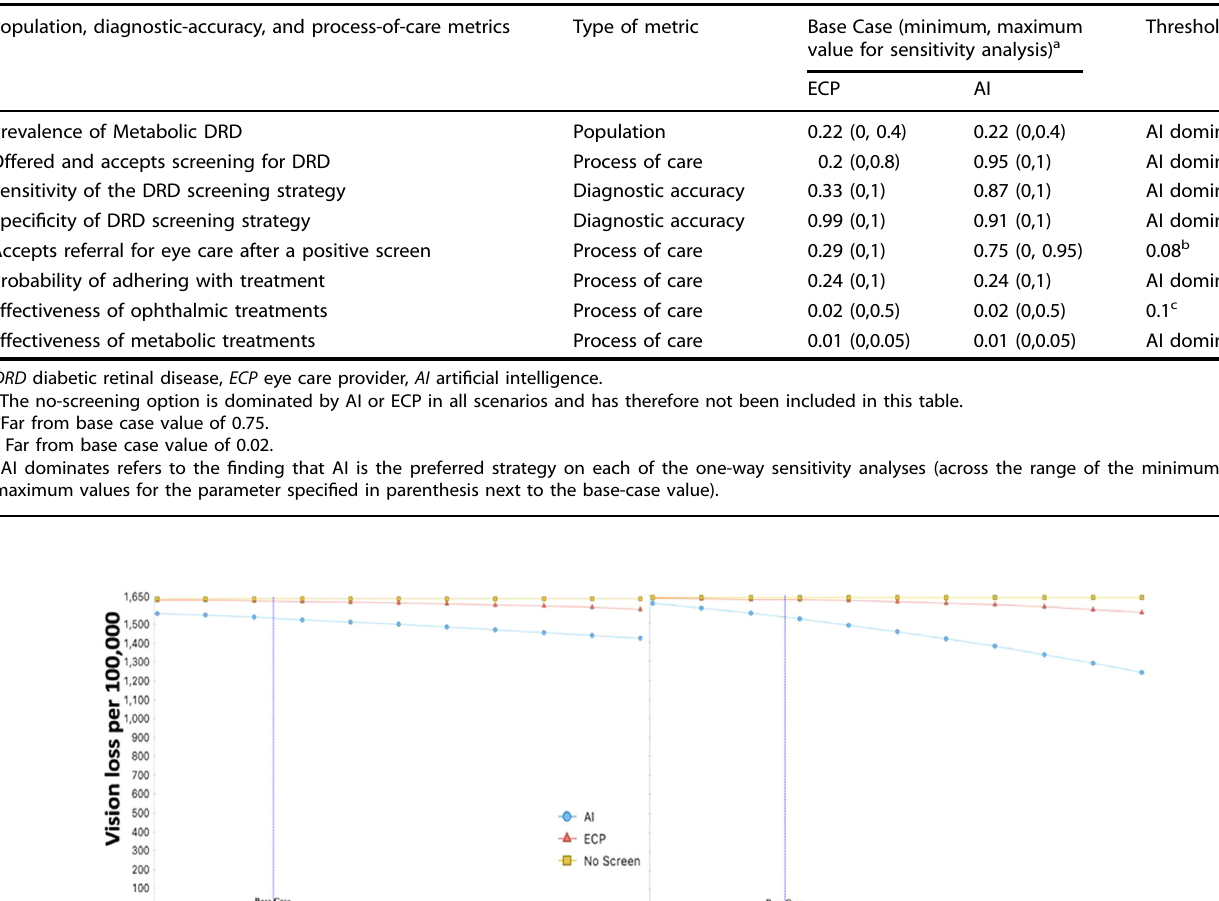
Table 2. One-way sensitivity analyses.